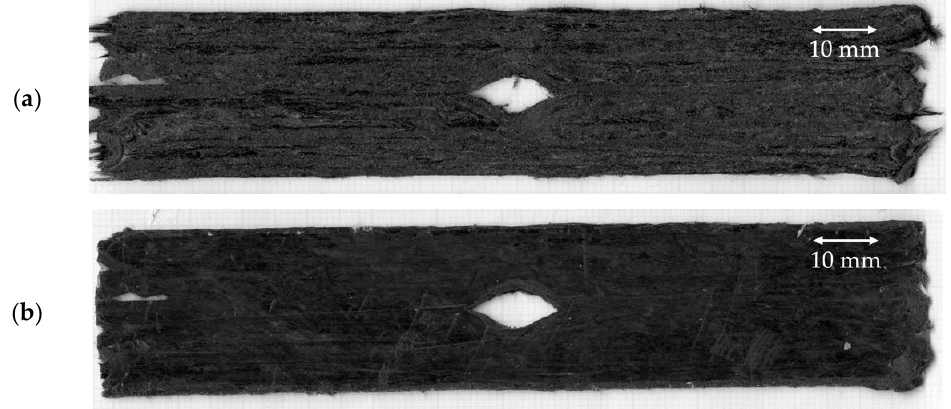
Figure 9. ( a ) 4-curvature printed part before post-printing consolidation; ( b ) the sample after the consolidation under heat and pressure (4C-Oven) showing a smoother surface and better raster fusion.